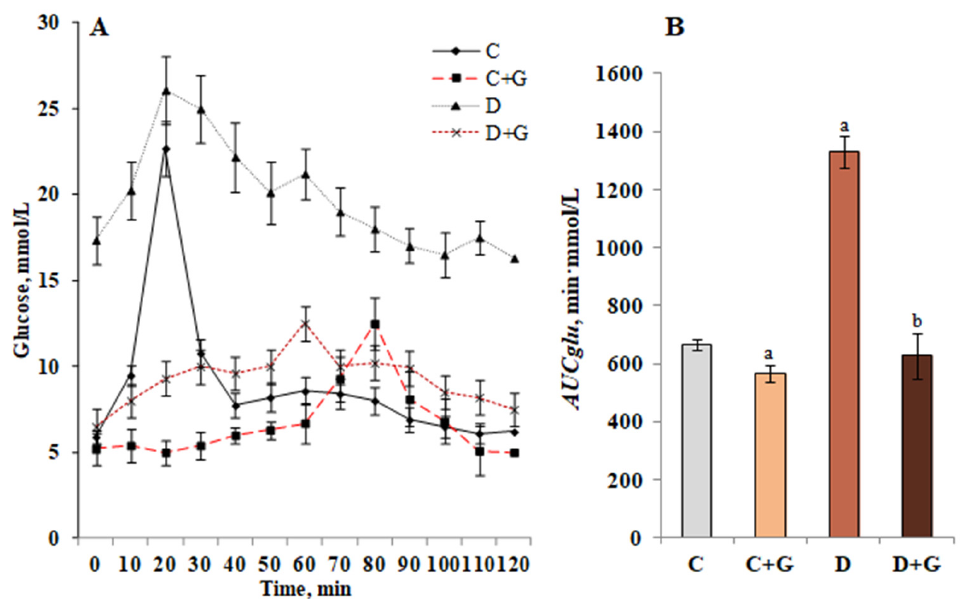
Figure 3. Glycemic curves ( A ) and the area under glycemic curves ( B ) in normal and DM conditions, as well as in the condition of Galega officinalis extract administration. a — p < 0.05, as compared with the control group; b — p < 0.05, as compared with the diabetes mellitus group.